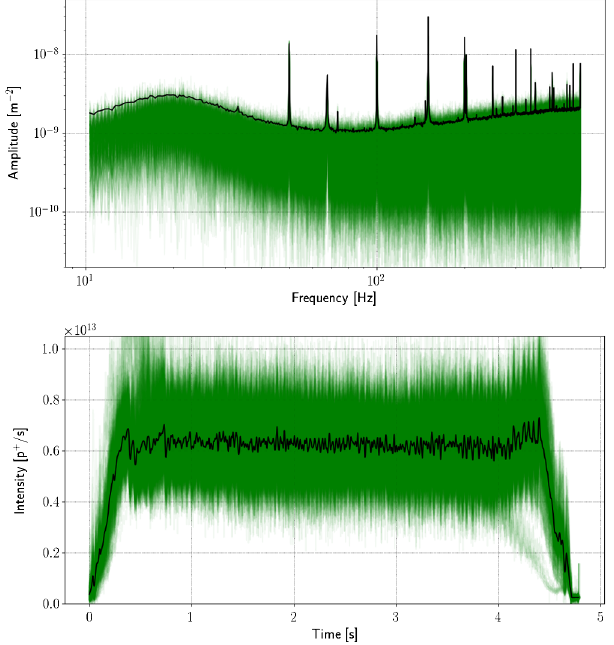
FIG. 13. Single measurements (green lines) and their average (black line) for the ripple quadrupole current (top plot) and extracted spill (bottom plot) during a physics run.